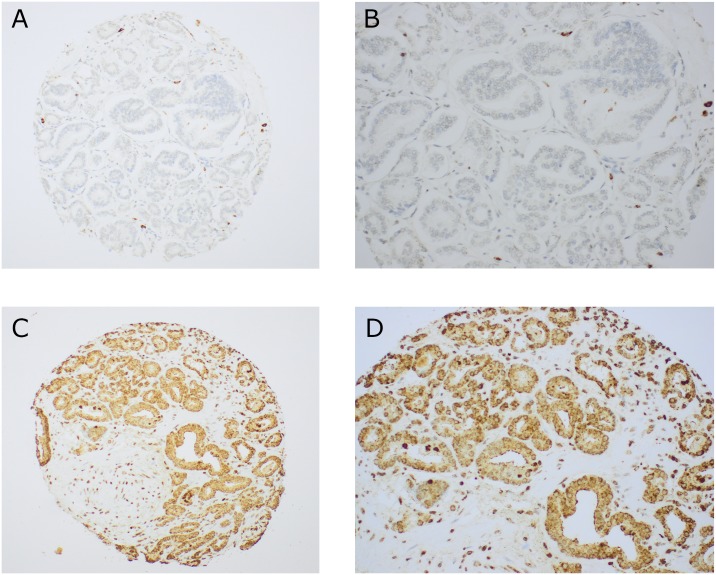
Illustrative examples of immunohistochemical staining for PRL3.A) a whole core at 200 magnification exhibiting low expression, B) An image of the same core as A at 400X magnification, C) a whole core at 200x showing high expression of PRL-3, D) an image taken 400x in the same core as C. This image also serves as an example of high expression in fibroblast nuclei.